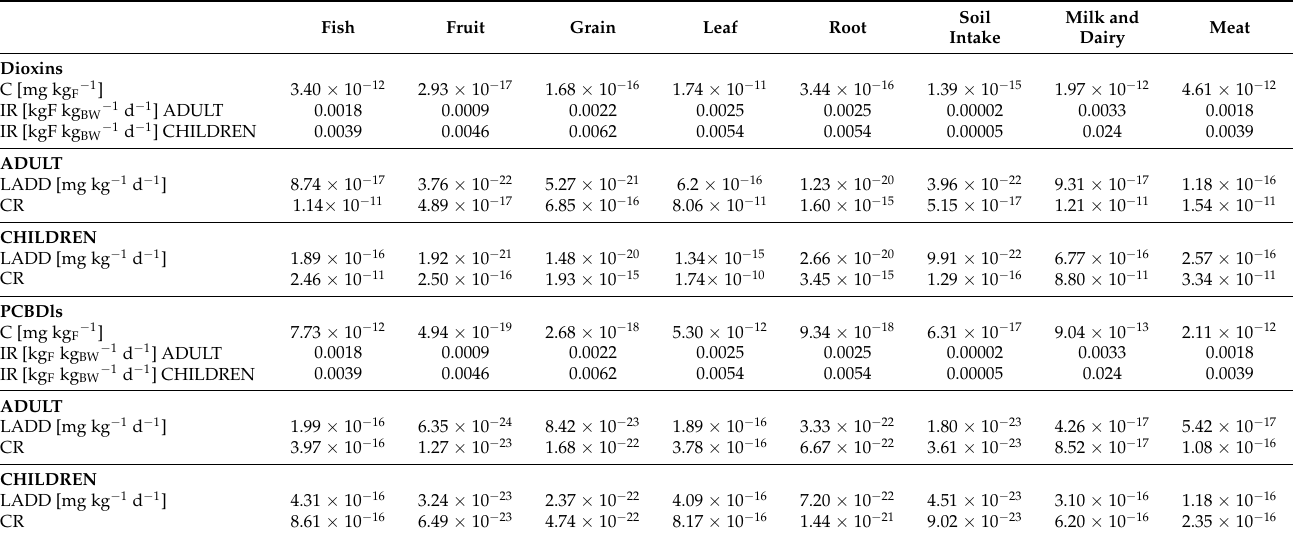
Table 6. Cancer Risk for dioxins and PCBDls for ingestion.